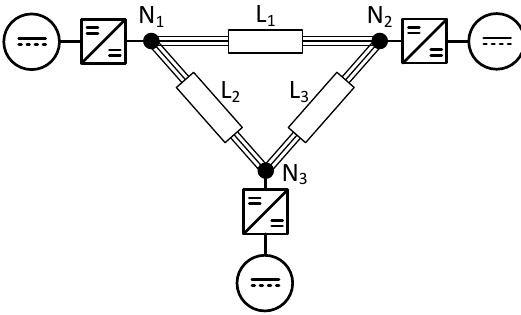
Figure 6. Example of a DC distribution grid with three nodes and three lines in a ring configuration.